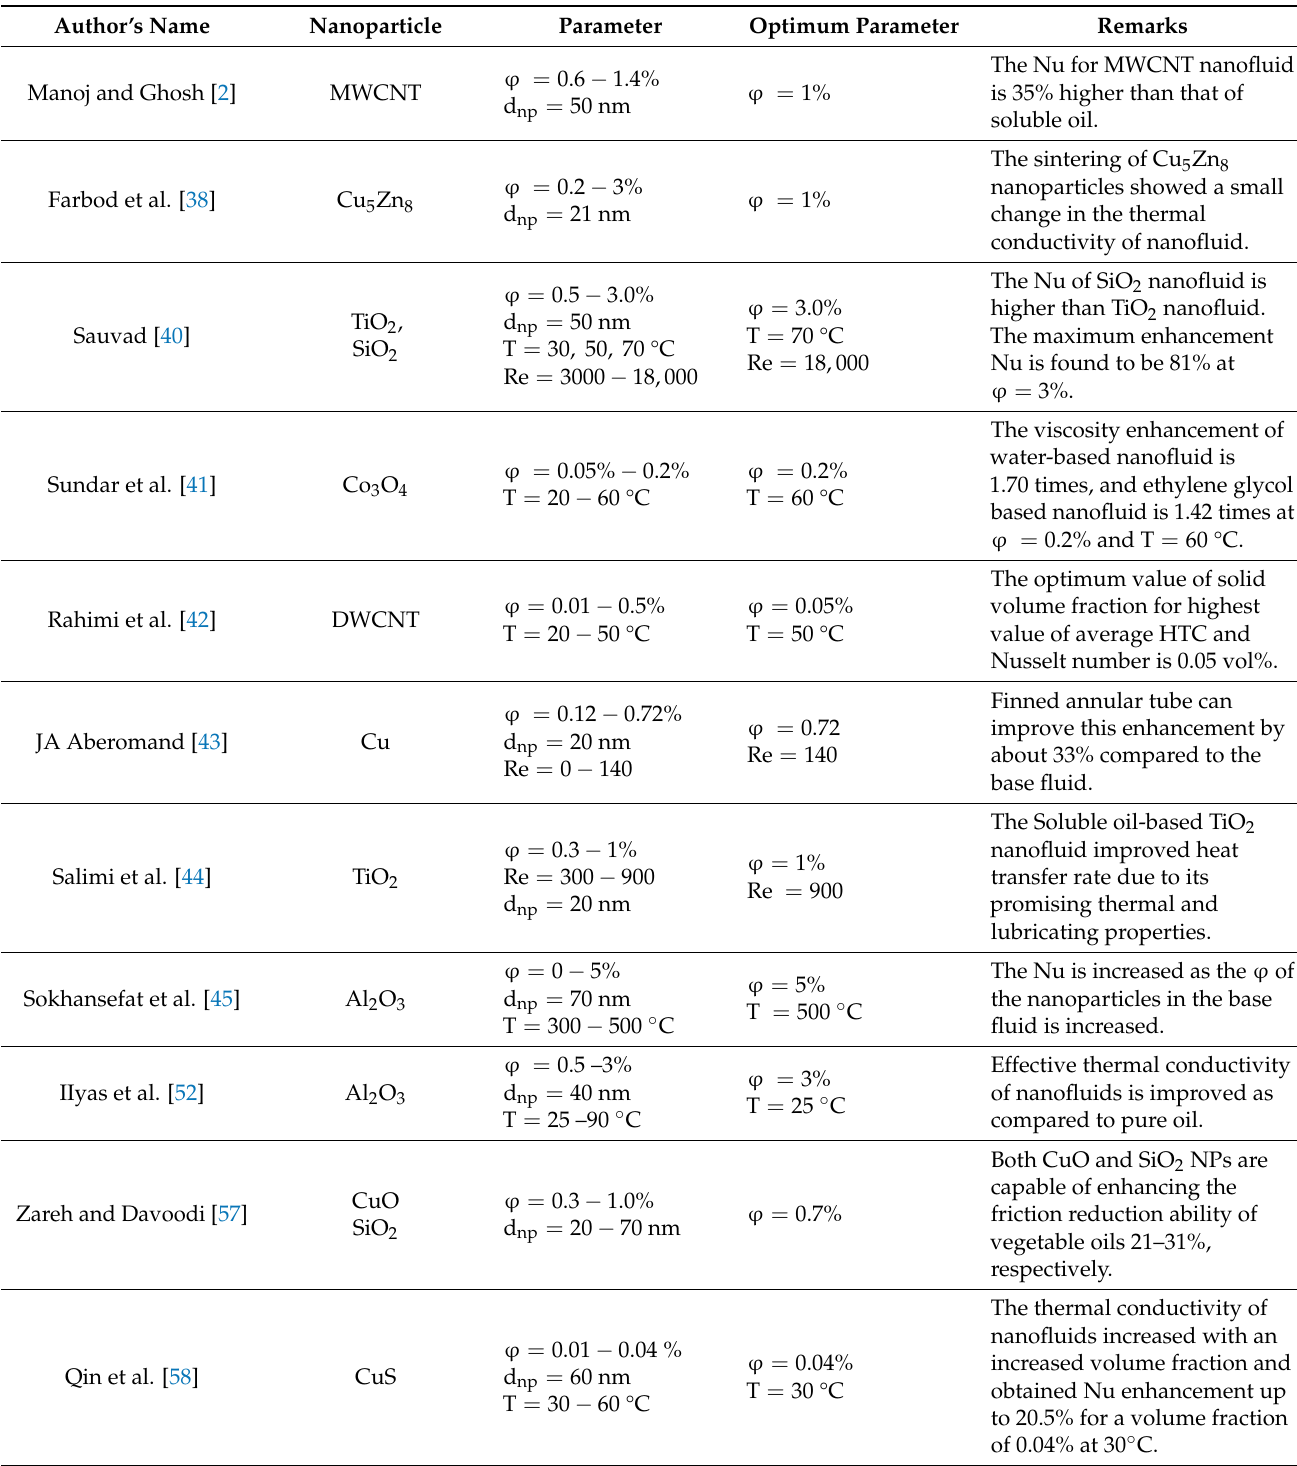
Table 6. Optimum parameters and major findings of oil-based nanofluids in previous